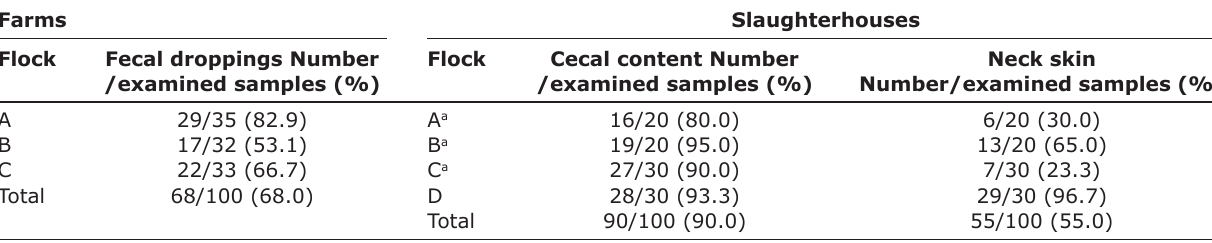
Table-2: Prevalence of thermophilic Campylobacter in the visited farms and poultry slaughterhouses.